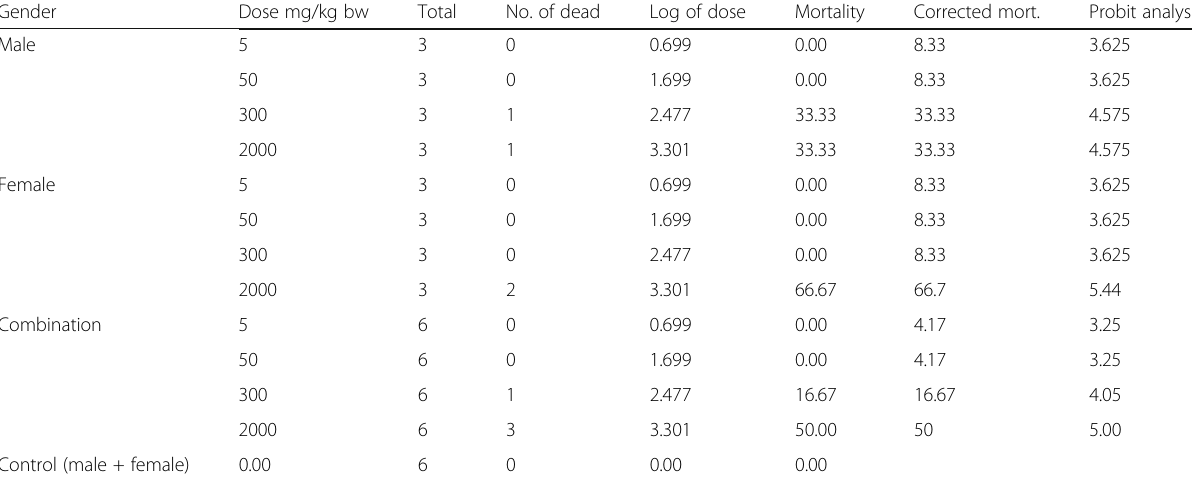
Table 1 Number of deaths by sex and dose for oral THJ-2201 Gender Mortality Corrected mort.